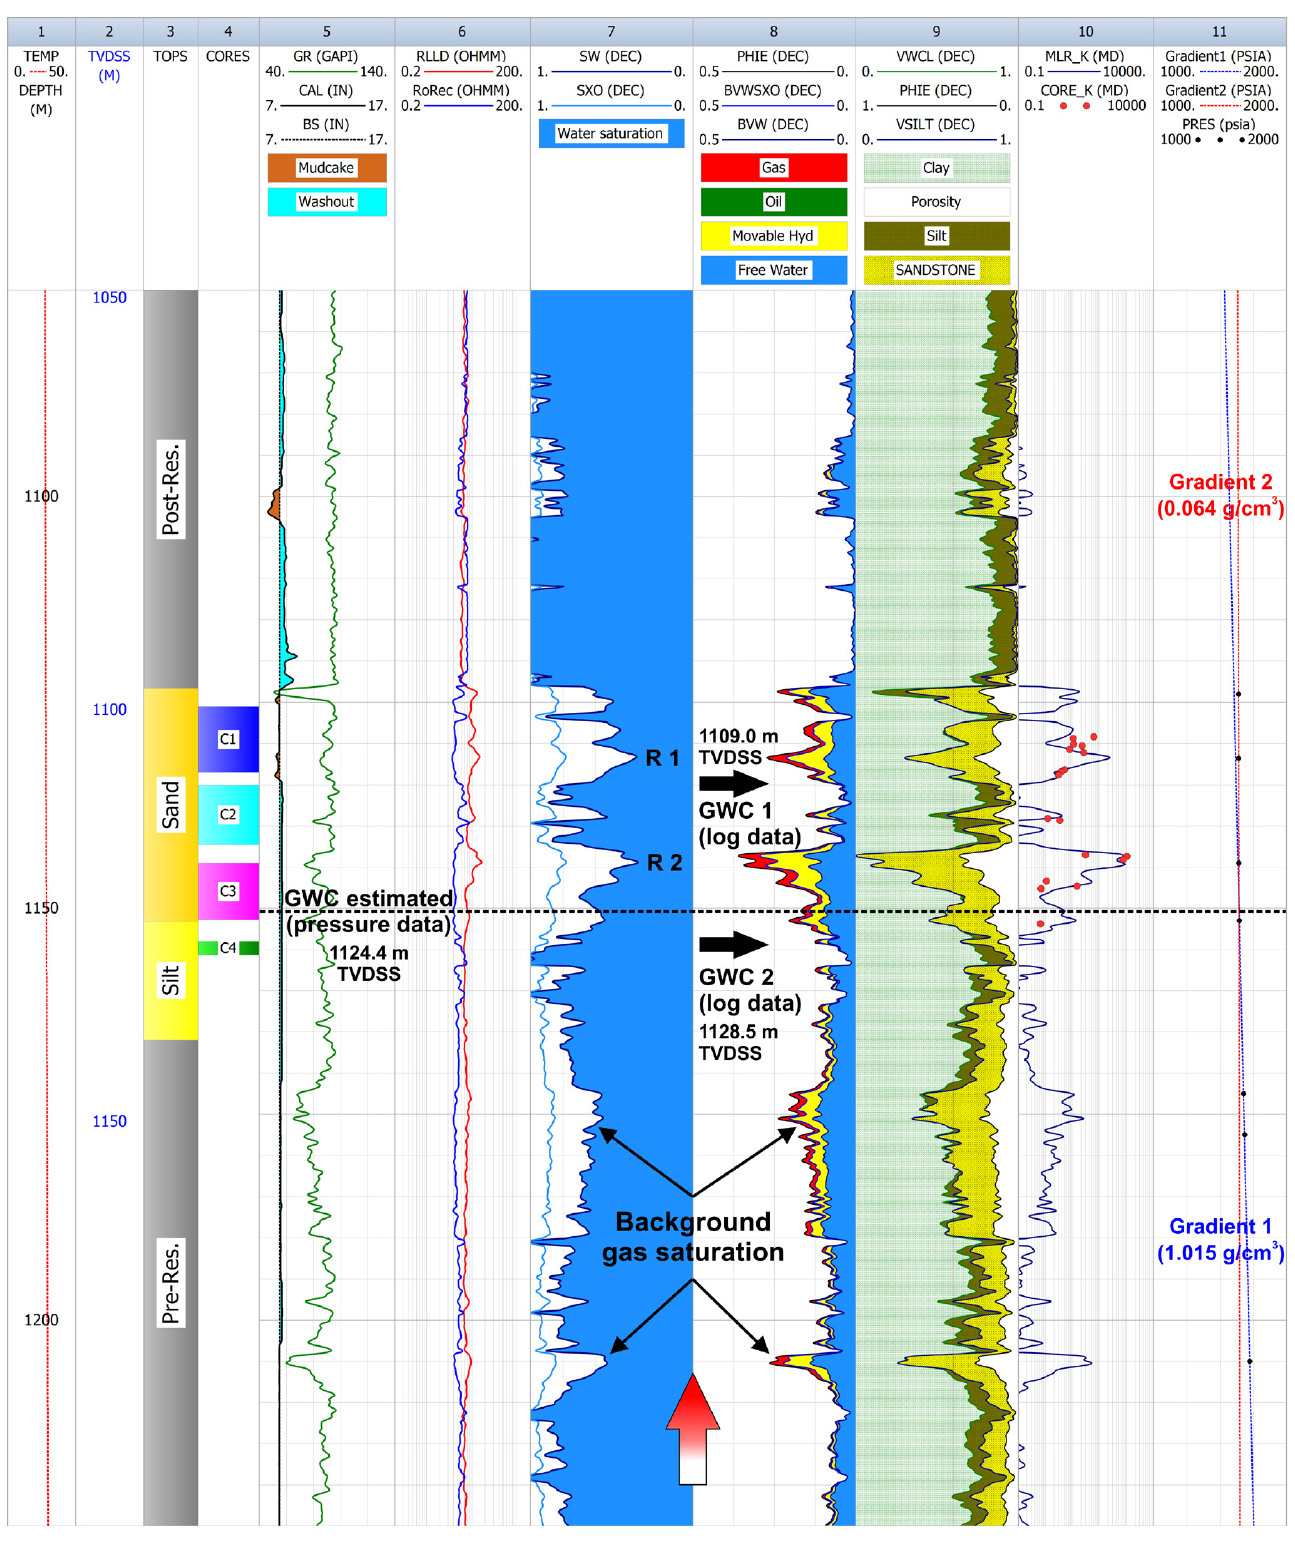
15 Figure 15. Example of deterministic log interpretation results for well B-2. TEMP —borehole temperature, GR —gamma-ray intensity, CAL —caliper, BS —bit size, RLLD —deep Laterolog apparent resistivity ( ≈ R t ), RoRec —reconstructed R 0